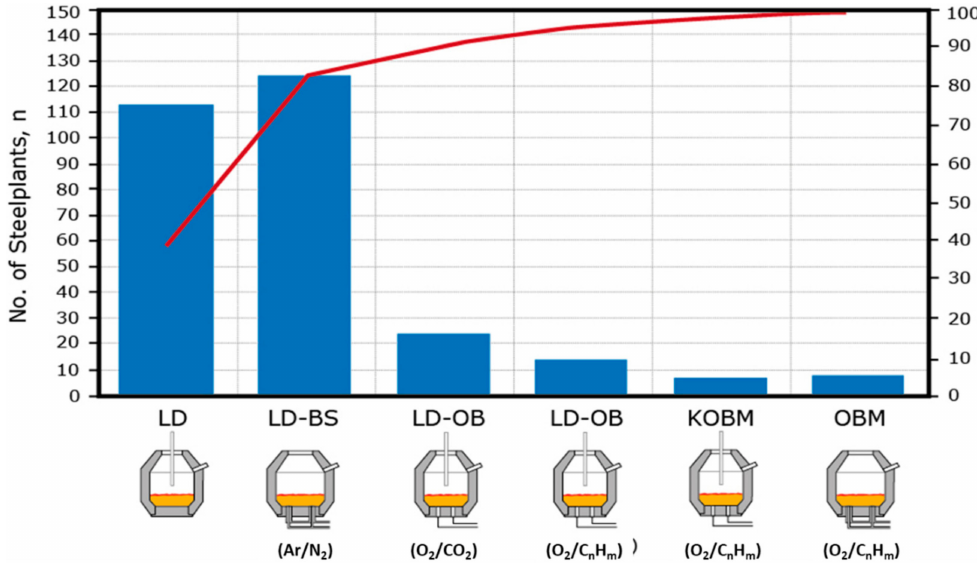
Figure 4. LD-process variants applied worldwide (2018) (the bars represent the number of installed converters and the red line represents the cumulative share of the six converter types).